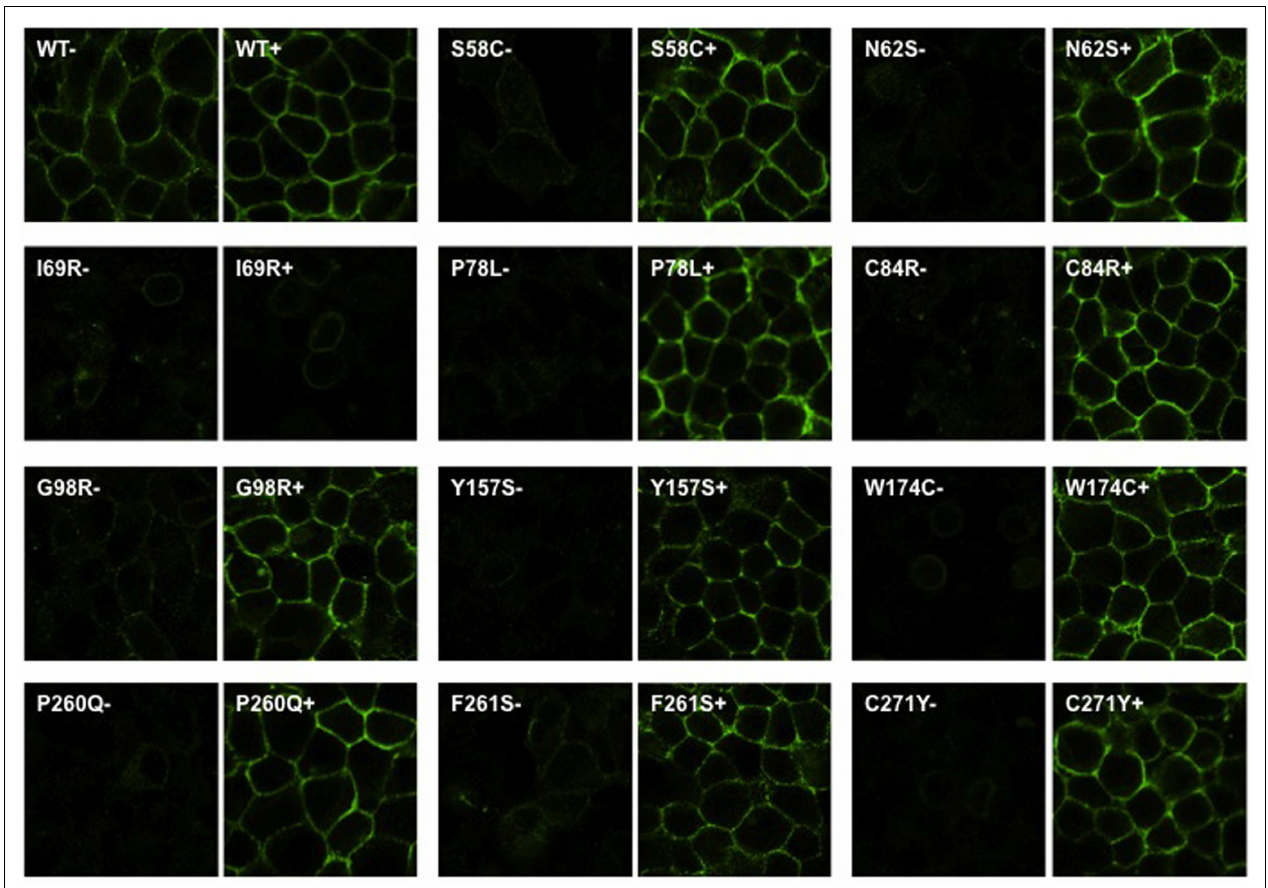
treated with 10 − 6 M Ipsen 5i for 24h and then stained with Alexa Fluor 488-conjugated antibody. Cells were visualized using a Nikon A1 confocal microscope. Results are representative of three independent